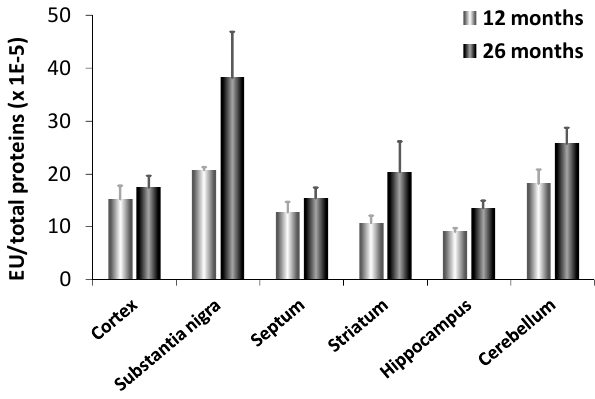
Figure 4. Enzyme activity of CN1 in different brain regions of adult (12 months) and senescent (24 months) rats